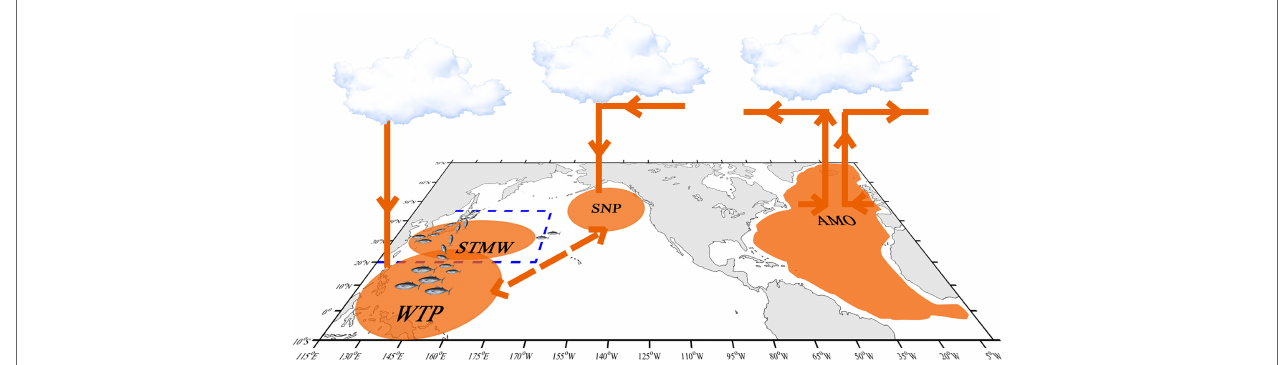
FIGURE 11 | Schematic process of SKJ in the Northwest Pacific affected by the AMO. The blue dotted line shows the study area in this paper. The orange patches, lines, and arrows show the possible affection process in the western pacific caused by the AMO in the north Atlantic (Sun et al., 2017; Wu et al., 2020b). SNP means subtropical North Pacific, WTP means western tropical Pacific, STMW means subtropical mode water in the study